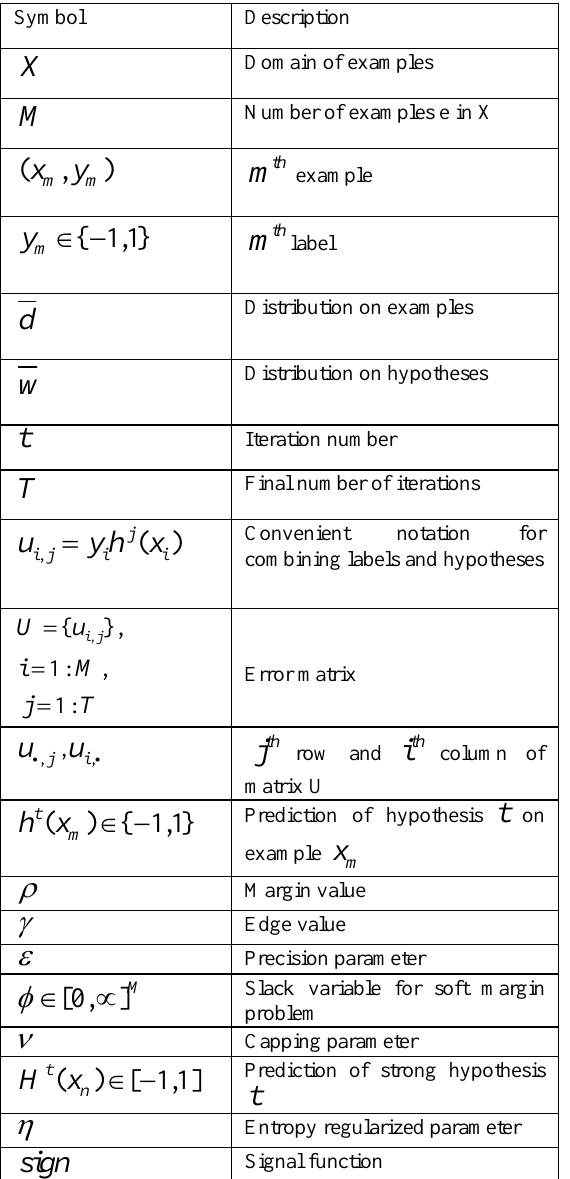
Table 1. Notation for margins, edges, and LPBoost Description Domain of